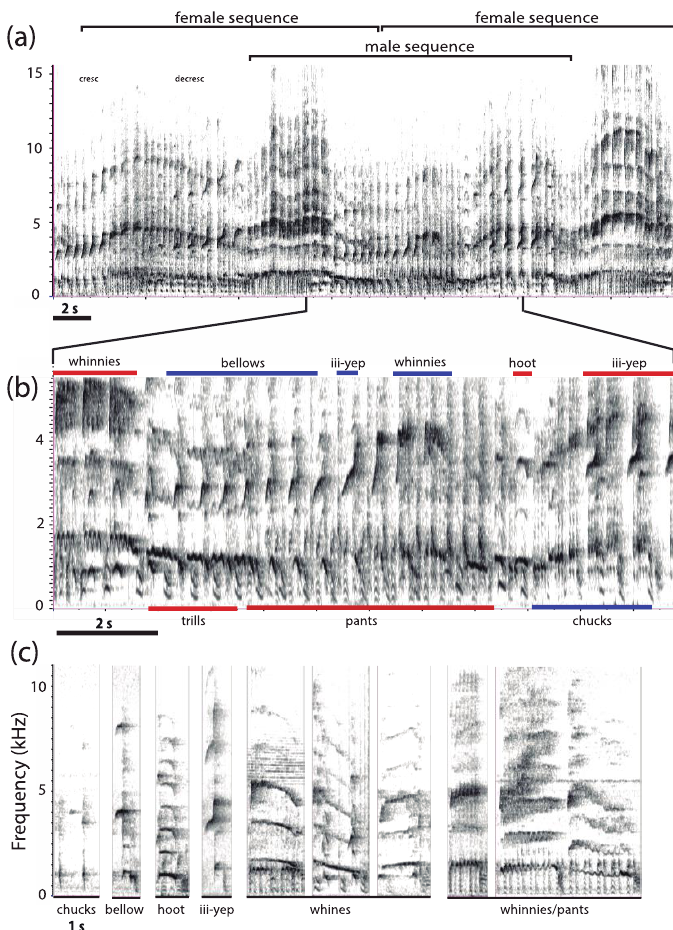
Figure 9. Vocal duet emitted by a pair of the San Martin titi monkey, P. oenanthe . ( a ) Periodic pattern showing two consecutive female sequences with overlapping male sequence. Note the crescendos of male bellows and female iii-yep syllables. The whole vocal display is accompanied by an exuberant amount of sound energy in the upper frequency range. ( b ) Segment of the same duet showing the respective contribution of the female (in red) and the male (in blue). The female first produces a series of whines, then a pant phrase followed by a series of iii-yep syllables. At the same time, the male contributes a long series of bellows that gradually merge into whines. ( c ) Examples of broadband and tonal syllables that appear to be unique to the San Martin titi monkey (iii-yep, whines, and whinnies). Many of these spectrograms contain vocalizations emitted by the two partners simultaneously.